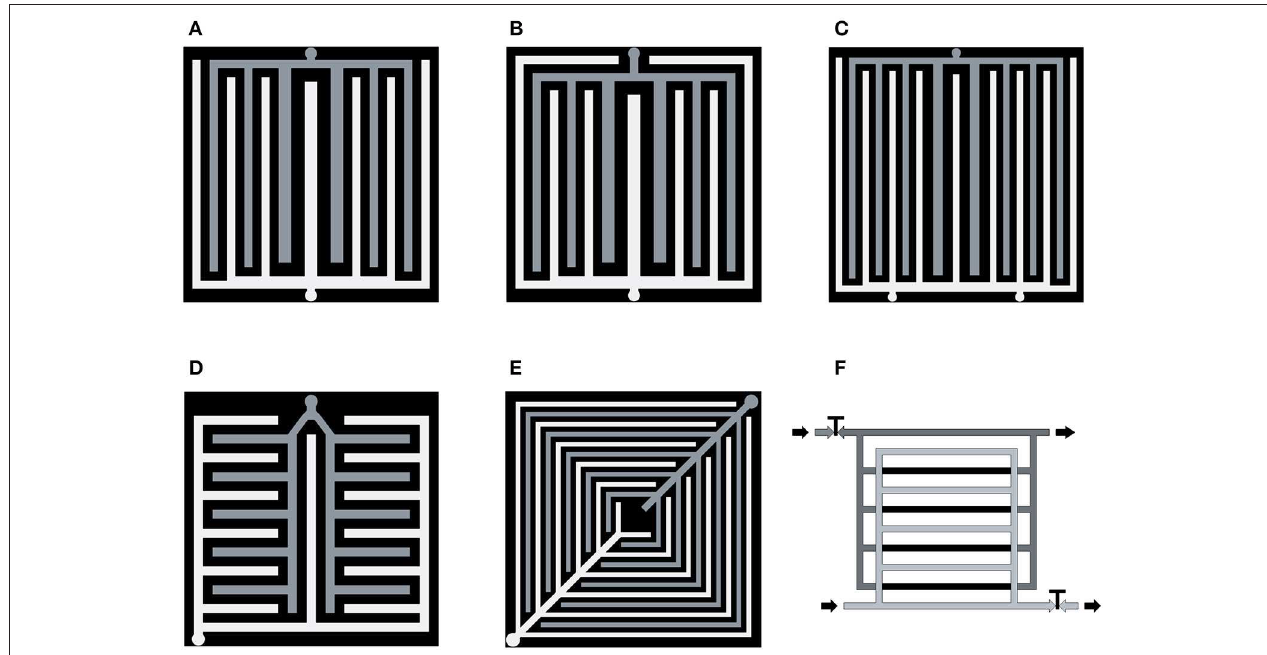
FIGURE 6 | Sketches of modifications of interdigitated designs: with two inlets (A) and perimeter channels (B) , with three inlets (C) from Arvay et al. (2015), non-fractal lung-type (D) and leaf-type (E) from Kloess et al. (2009), switched parallel-interdigitated type (F) , from Santamaria et al.